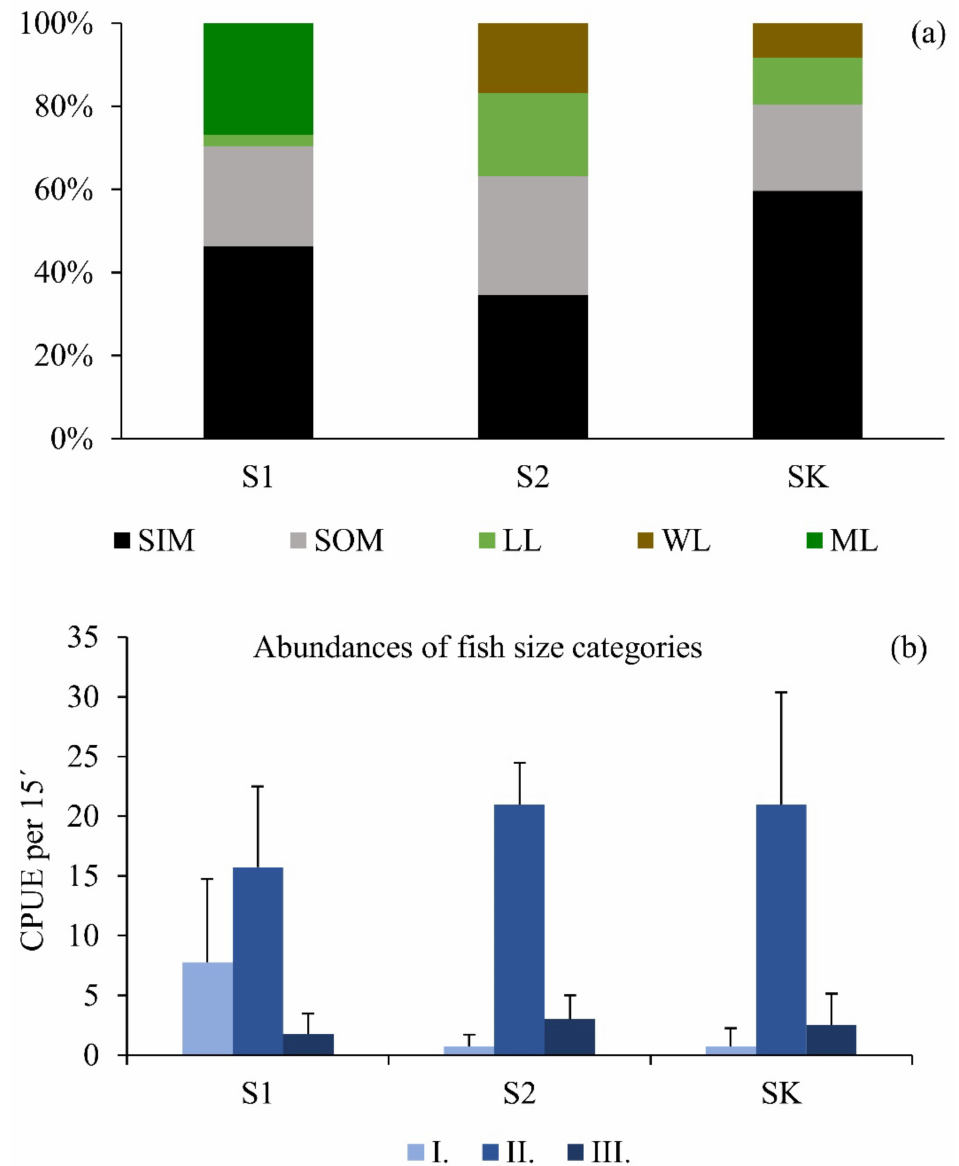
Figure 2. Contribution of ( a ) sediment type and ( b ) fish size distribution in the littoral zone of three SWB (S1, S2, SK). ( a ) abbreviations: SIM—Sediment Inorganic Matter, SOM—Sediment Organic Matter; LL—Leaf litter; WL—Wood Litter; ML—Macrophyte Litter. ( b ) abbreviations for fish size categories based on their body length: FI (<5 cm), FII (5–10 cm), and FIII (>10